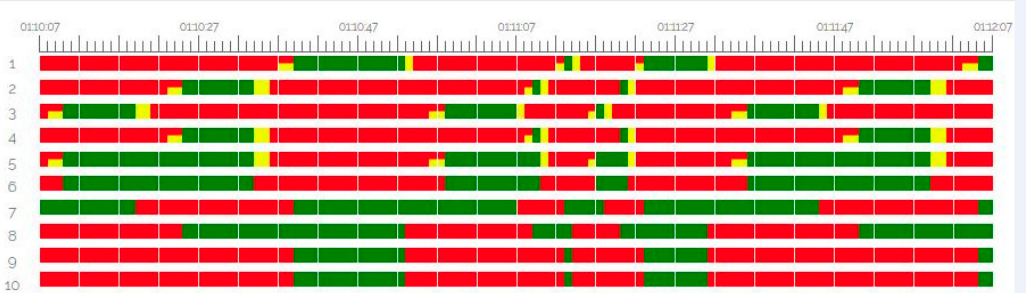
Figure 3. Transitions of signal plans [38] .